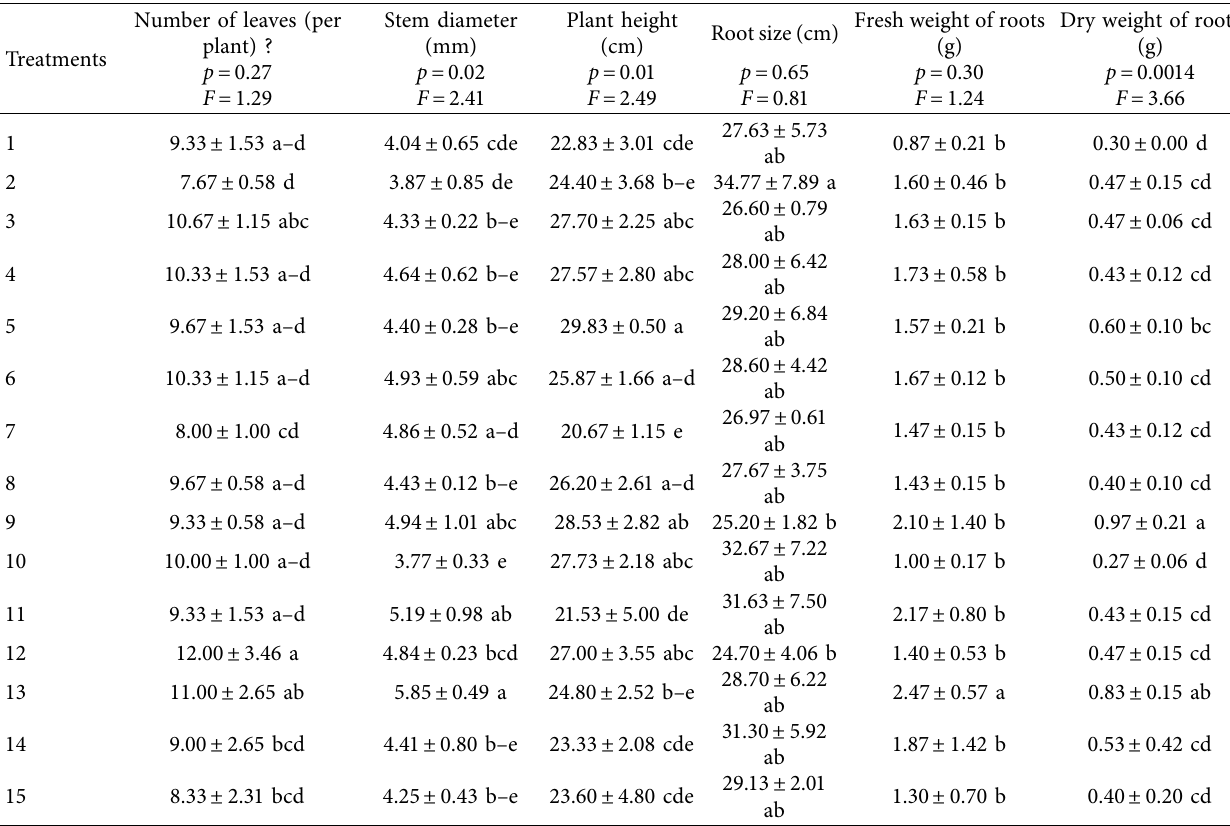
Table 4: Mean values and standard deviation of agronomic variables according to the treatments